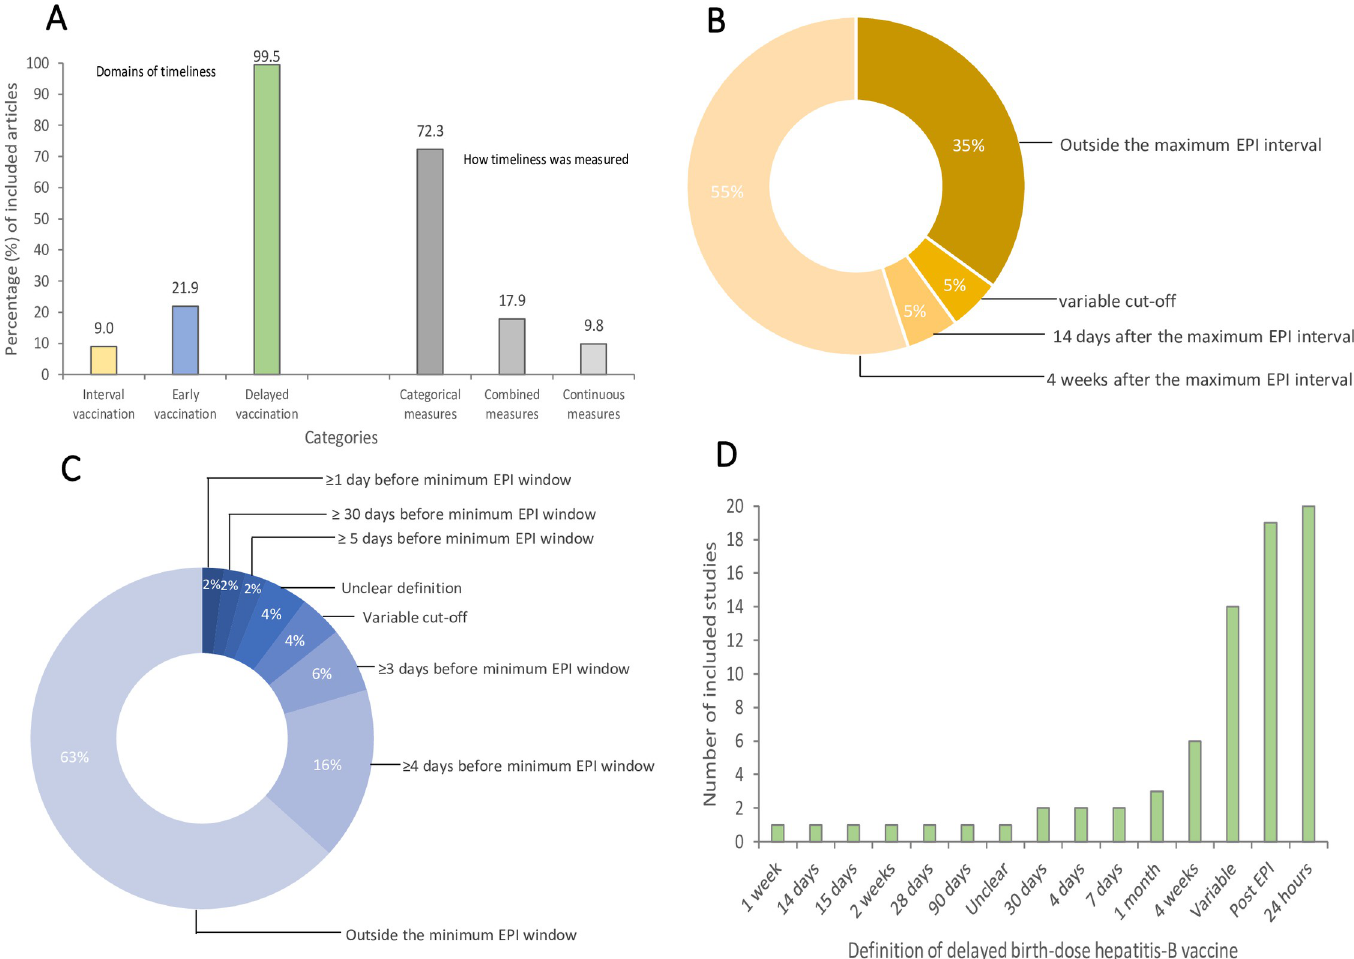
Fig 4. How the timeliness of routine childhood vaccination was defined and measured in the literature, 1978–2021 (a) domains of timeliness explored and how timeliness was operationalised (b) how untimely interval vaccination was defined (c) how early vaccination was defined (d) how delayed birth-dose hepatitis-B vaccine (HBV-BD) was defined. Note, in Fig 4D, the definition timelines are relative to the day of